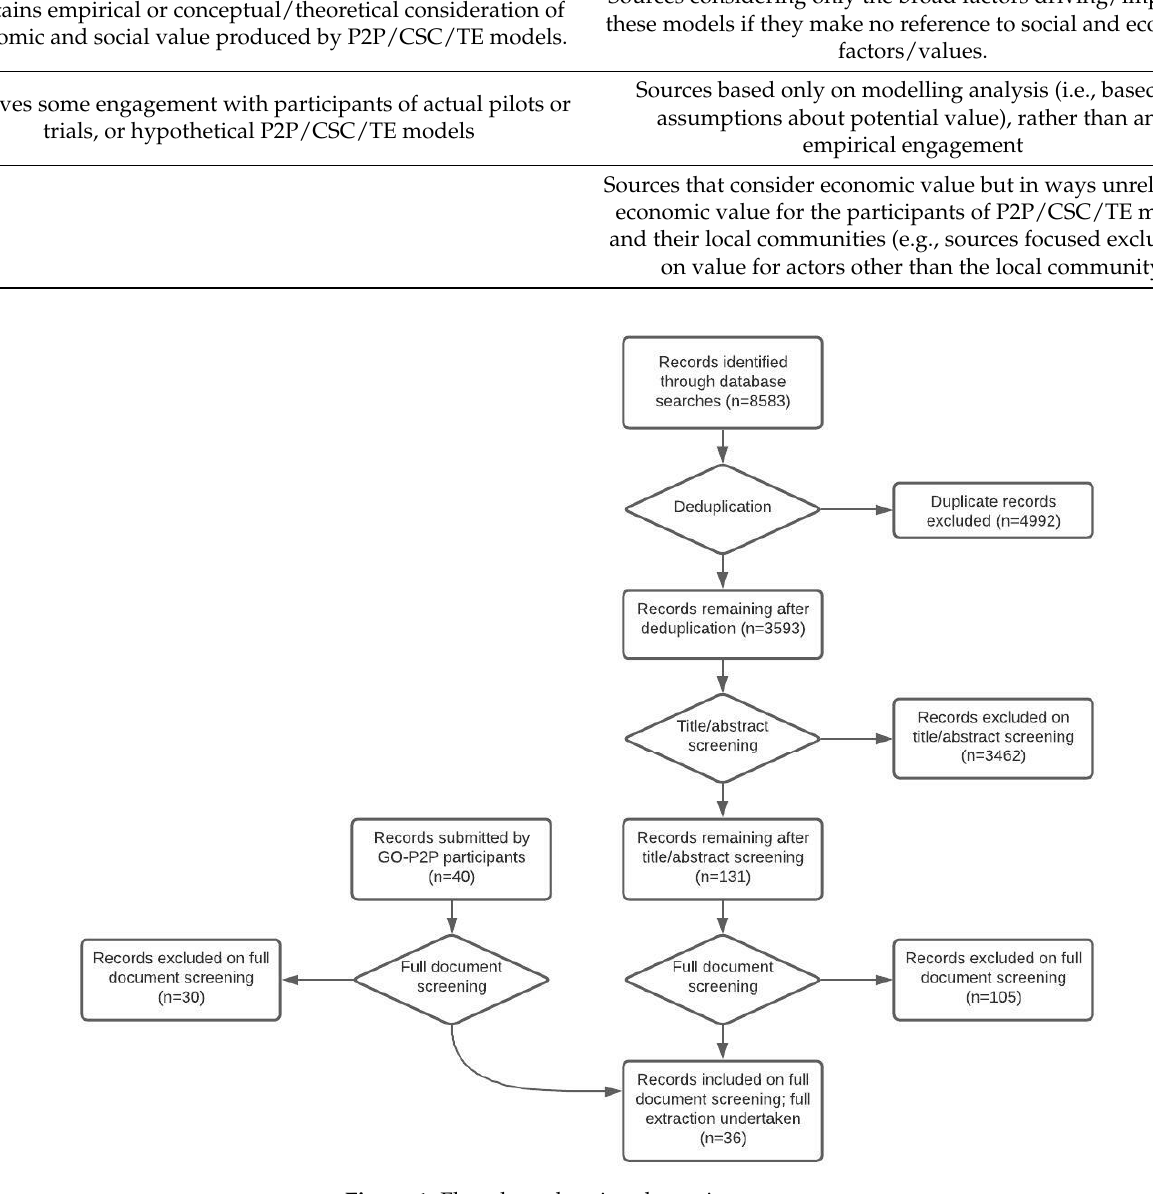
Figure 1. Flowchart showing the review process.